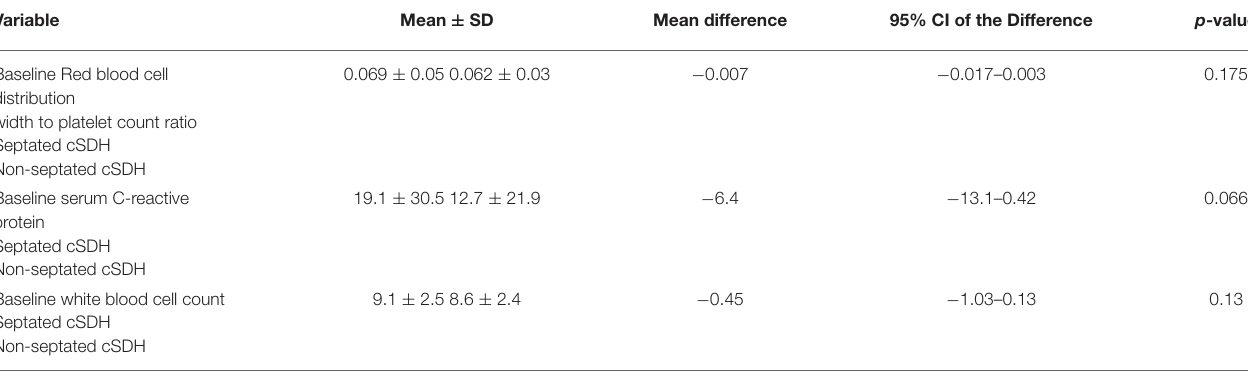
TABLE 2 | Comparison of baseline inflammatory markers in patients with or without septated chronic subdural hematomas (using independent t